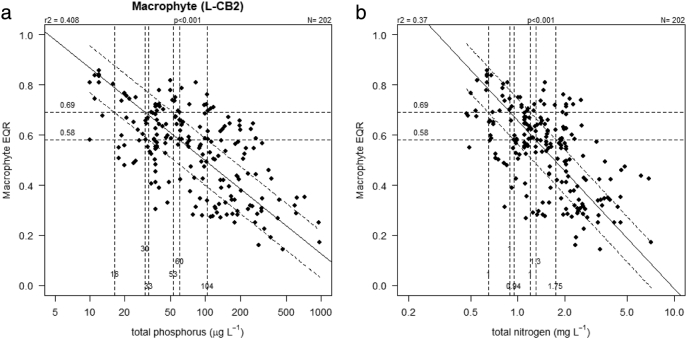
Relationship between common metric for macrophytes and a) total phosphorus and b) total nitrogen for high alkalinity very shallow (L-CB2) lakes showing high/good and good/moderate boundaries. Solid line shows type II RMA regression, dotted lines show upper and lower quartiles of residuals.